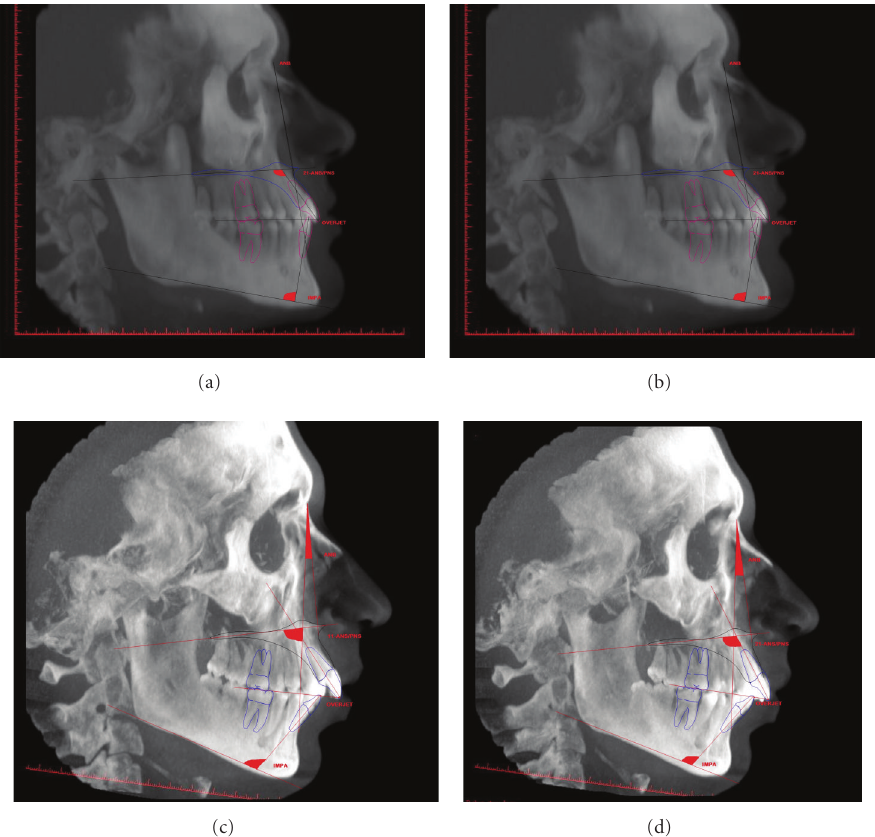
Figure 1: Examples of CBCT right and left of two subjects. The first two figures belong to a subject with ANB 0 ◦ –4 ◦ (skeletal class I), the second two to a subject with ANB > 4 ◦ (skeletal class II). In the images, axes and angles like ANB, IMPA, U1-bispinal plane, and overjet were drawn to explain the aim of this work. In the research, each parameter was analysed via NNT NewTom 3G software using particularly secondary